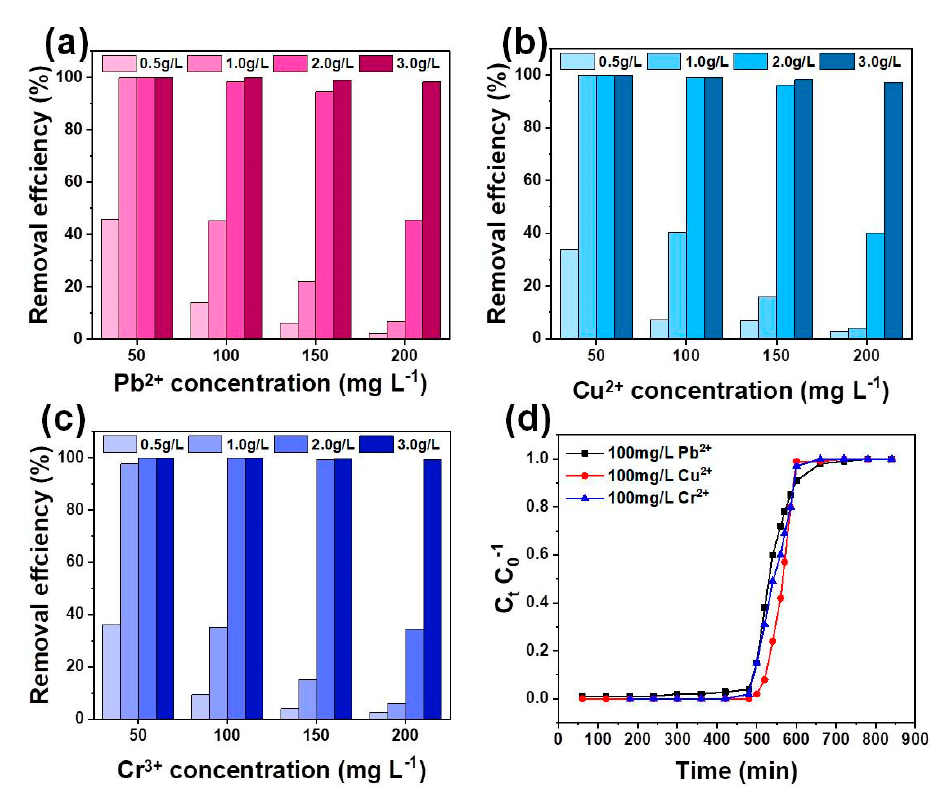
Figure 10. The effects of the absorbent dosages and the initial concentration of the solution coexisting with ( a ) Pb 2+ , ( b ) Cu 2+ and ( c ) Cr 3+ on the removal efficiency of each metal ion, ( d ) kinetics of column adsorption of heavy metal ions in practical wastewater.